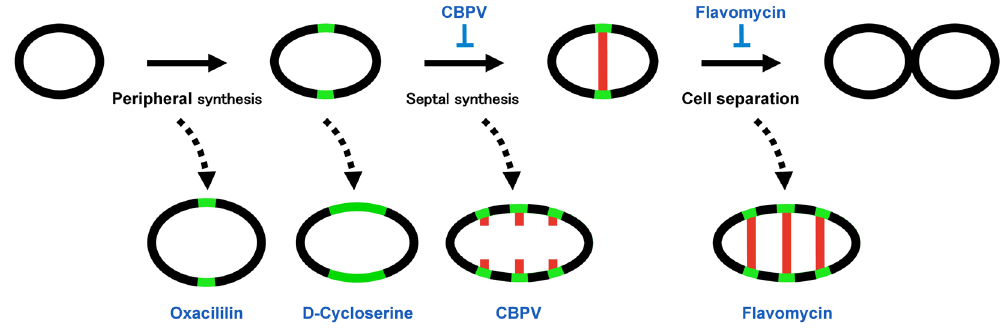
Figure 8. Inhibitory effects of antibiotics on S . pyogenes cell